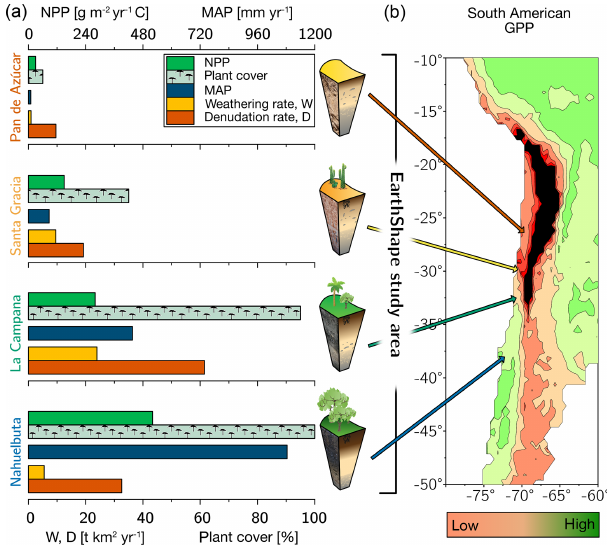
Figure 1. The climate and vegetation gradient of the four Earth- Shape study sites (from arid to humid: Pan de Azúcar, Santa Gra- cia, La Campana, and Nahuelbuta). (a) Net primary productivity (NPP), plant cover, and annual precipitation (MAP). Denudation rate ( D ) and weathering rate ( W ) were determined with cosmo- genic 10 Be. (b) Position of the four study sites in South America and their respective gross primary productivity (GPP) derived from the FLUXNET database (Jung et al., 2011). Black is used to indi- cate very low GPP in the Atacama Desert. The uncertainties are not shown for clarity. They are provided in Table